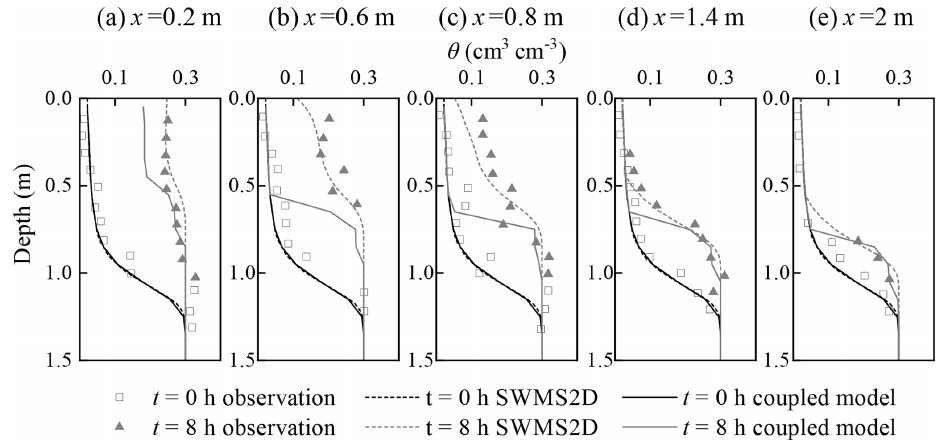
Figure 6. Comparison of soil water content profiles between the simulations from the coupled model, SWMS2D, and the observations at different locations: (a) x = 0 . 2m; (b) x = 0 . 6m; (c) x = 0 . 8m; (d) x = 1 . 4m; (e) x = 2m.